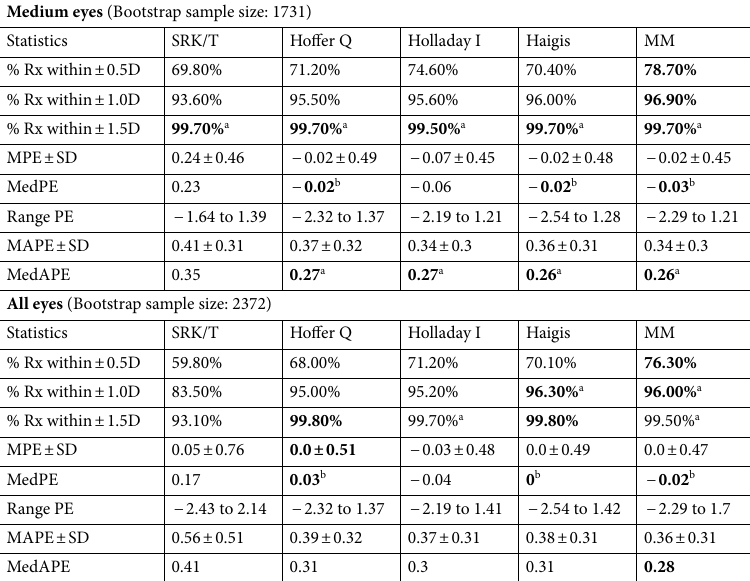
Table 6. Summary statistics of the cross-validation results for each of the five formulae (SRK/T, Hoffer Q, Holladay I, Haigis and MM) for medium and all eyes. % Rx Percentage of eyes within a given range of prediction error, MPE Mean prediction error, MedPE Median prediction error, Range PE Range of the prediction error, MAPE Mean absolute prediction error, MedAPE Median absolute prediction error, SD Standard Deviation of the error. a No statistically significant difference at level 0.05. b No statistically significant difference from zero at level 0.05. Significant values are in